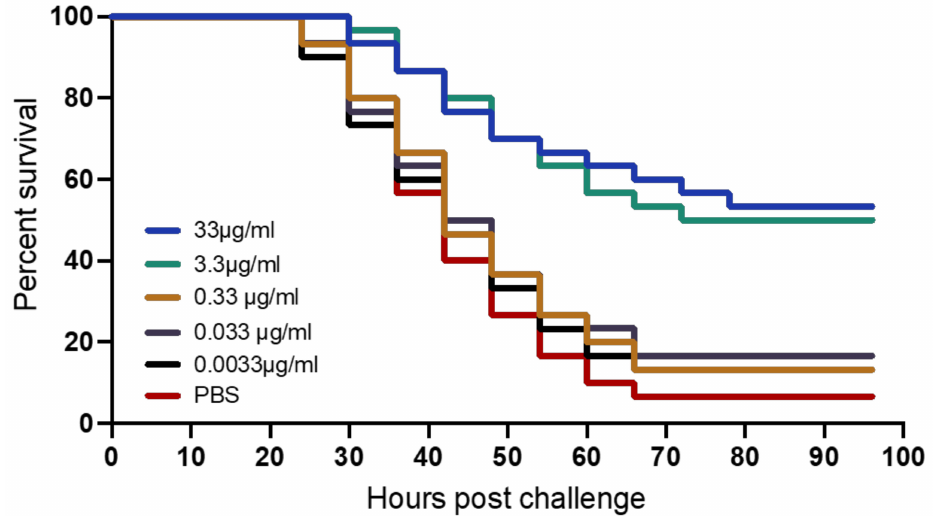
Figure 6. Kaplan Meyer’s post challenge survival analysis of zebrafish larvae challenged with Lacto- coccus garvieae after treatment with five different concentrations (33 µ g/mL, 3.3 µ g/mL, 0.33 µ g/mL, 0.033 µ g/mL, and 0.0033 µ g/mL) of